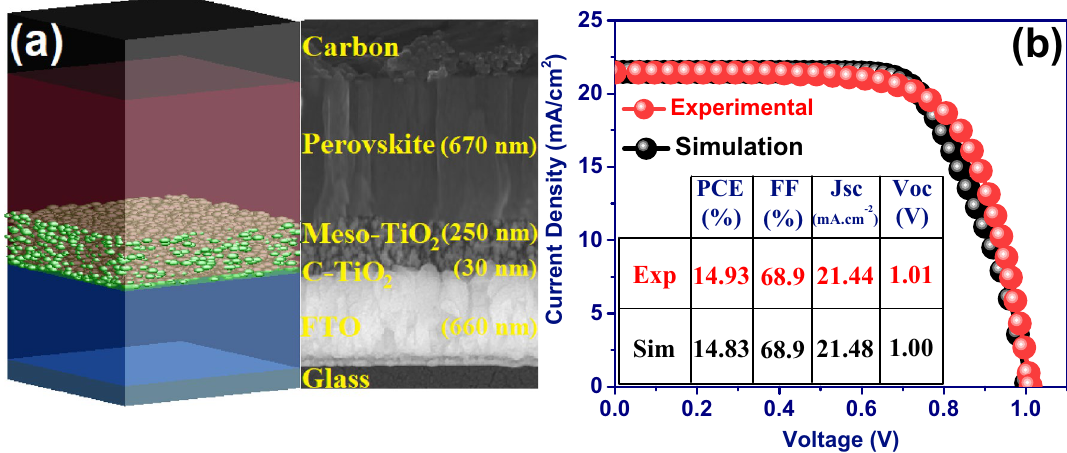
Figure 1. ( a ) Device configuration used for simulation and cross-section image of the experimental HTL-free carbon-based perovskite solar cell. ( b ) The photocurrent density–voltage (J-V) curves from experimental and simulation validation of the perovskite solar cell. J-V characteristics of the devices have been measured under one sun simulated